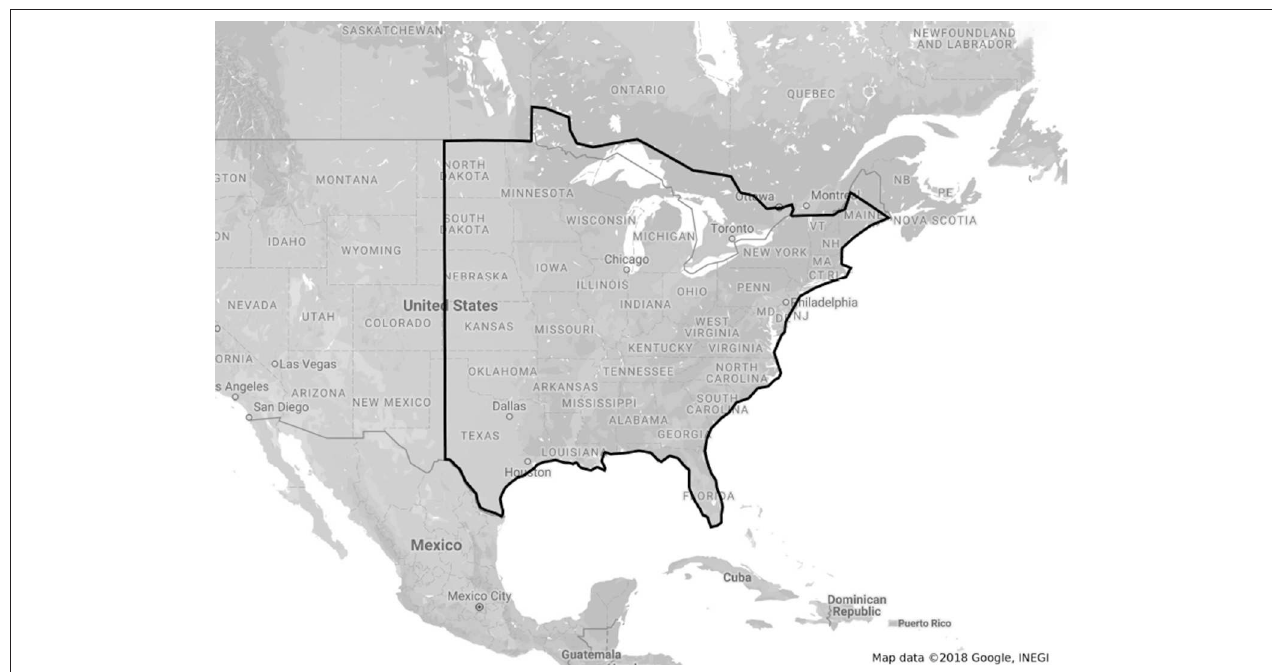
FIGURE 1 | Sampling area. The sampling area includes the 35 eastern-most states of the US and Canada (Ontario), representing all areas where there is more than a 50% probability that monarch populations are present for breeding purposes. Geographically speaking, the US-Mexican Border, parallel 49, meridian 102, and the east coast constitute the southern, northern, western, and eastern limits of the sampling area,